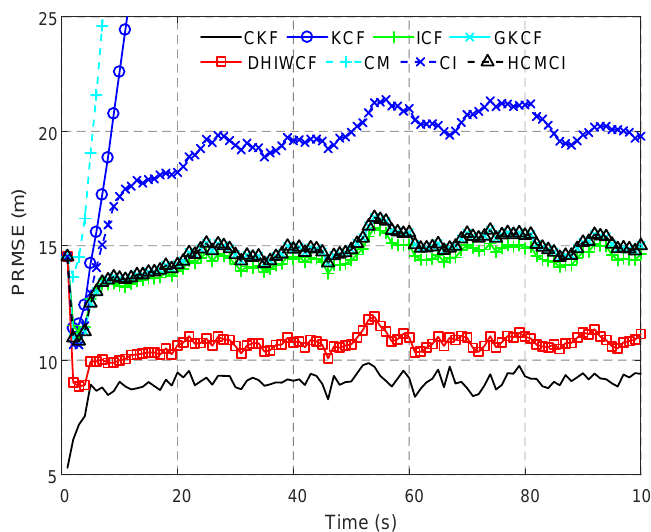
Figure 3. Position root mean squared error (PRMSE) averaged over all 8 nodes and 200 Monte Carlo runs.